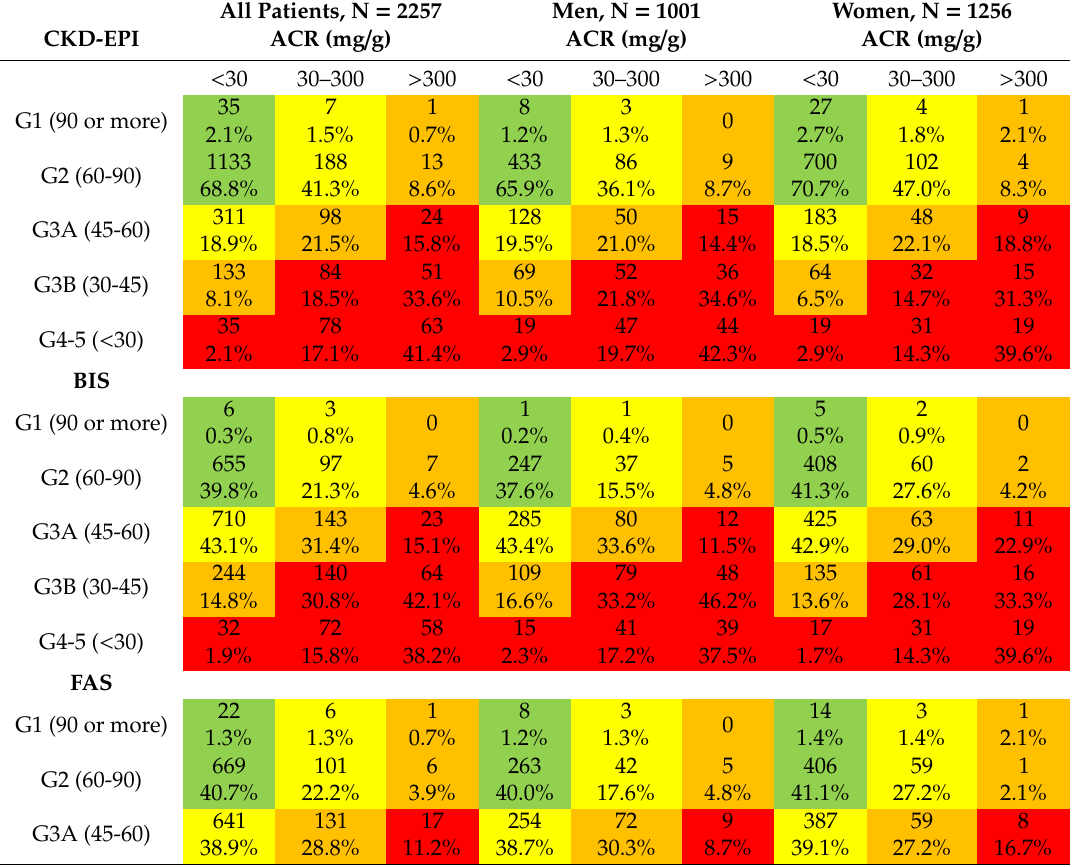
Table 3. Prevalence of KDIGO stages with three di ff erent equations stratified by sex. All Patients, N = 2257 Men, N =